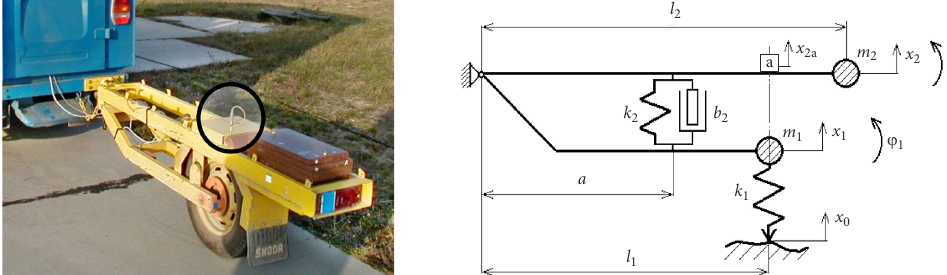
Figure 3. Mechanical scheme of UNIZA single-wheel vehicle JP VSDS (Decký, Kováč